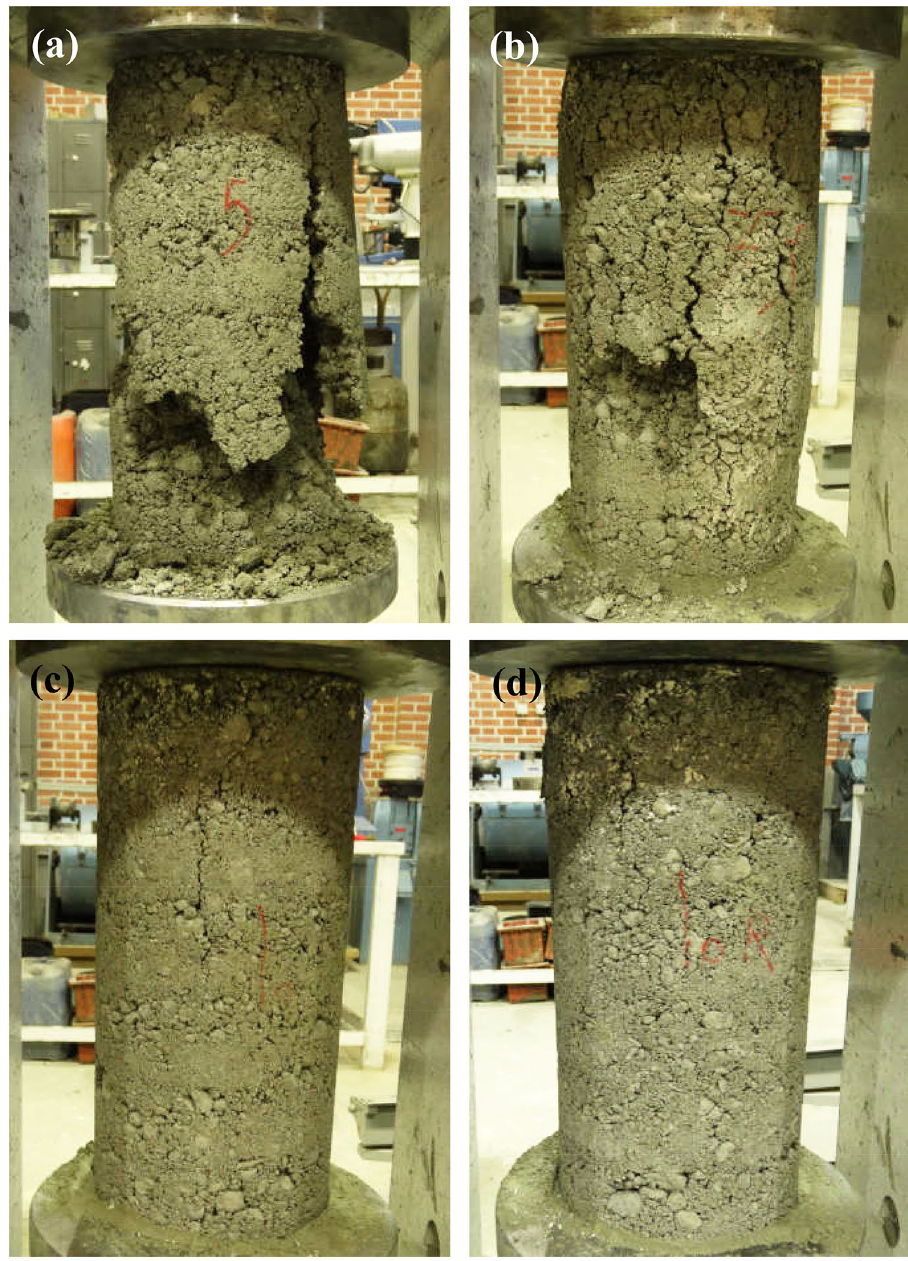
Fig. 10 The failure mode of CSG material in uniaxial compression test at the age of 28 days; a 5% cement, b 7.5% cement, c 10% cement, d 12.5%